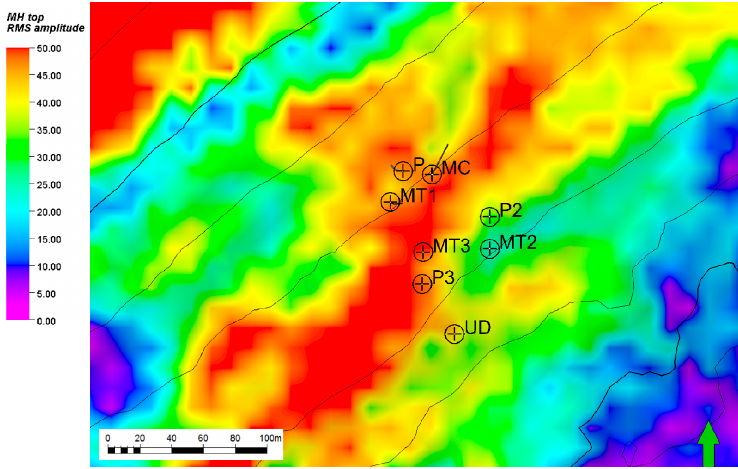
Figure 6. RMS amplitude map generated from the top of the MHCZ horizon around the production test site.